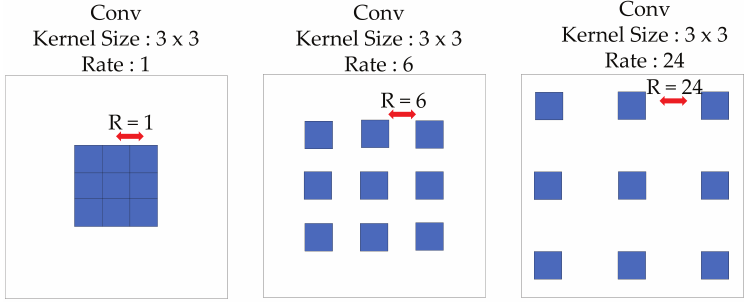
Figure 3. Basic concept of Atrous convolution in 2D image